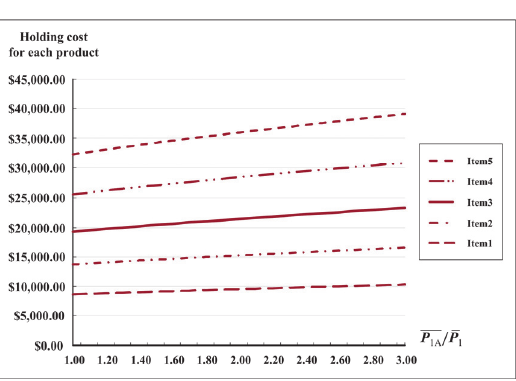
Fig. 4. Impact of differences in holding cost for each